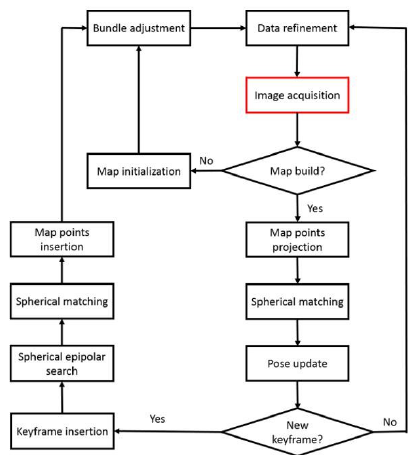
Figure 4. The flow of our full-view SLAM system.